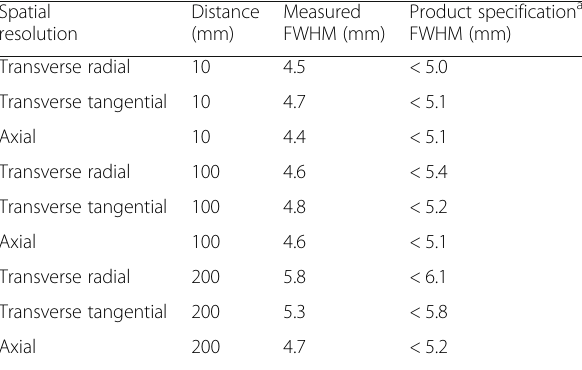
Table 3 Spatial resolution measured for the PET component of the Celesteion system